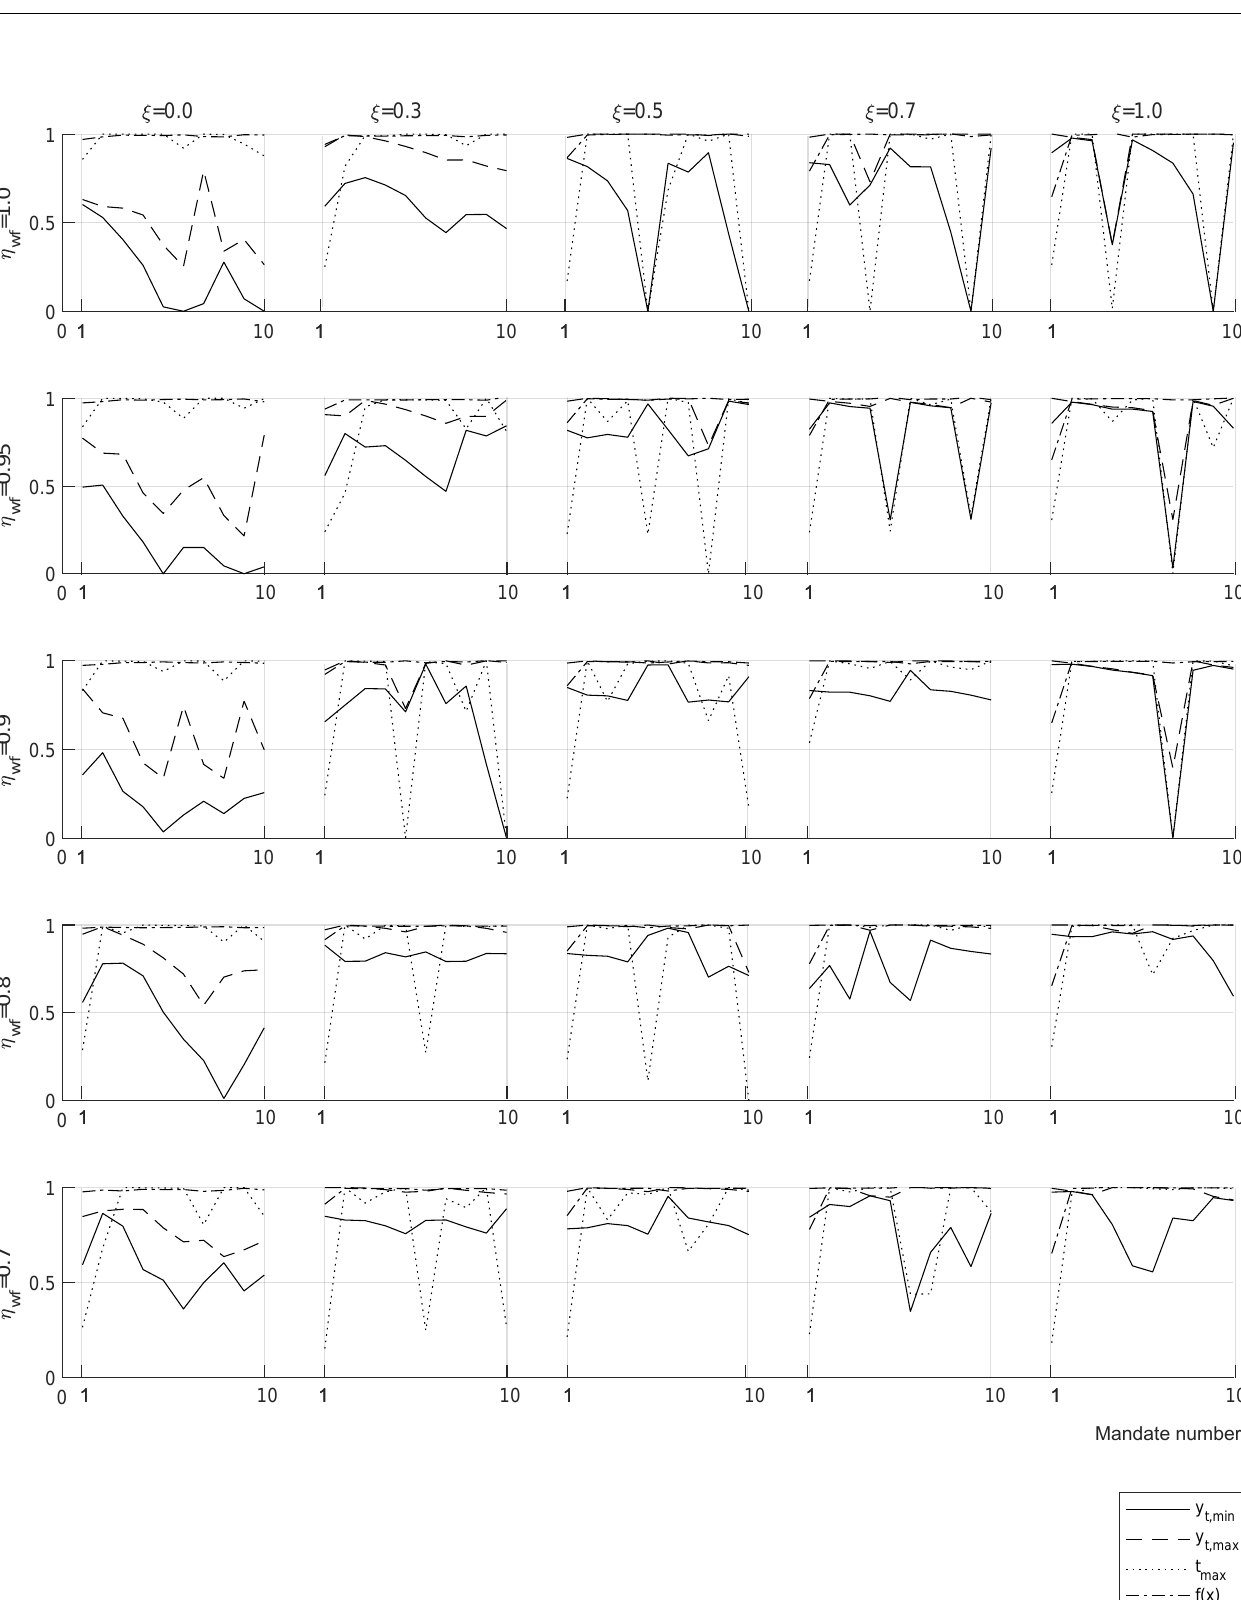
Figure A3. Tax policy evolution under yardstick vote during ten mandates for a series of welfare efficiency values η wf and tax disincentive ξ . Median criterion. Mandate length: 4 years. Vote constrained by